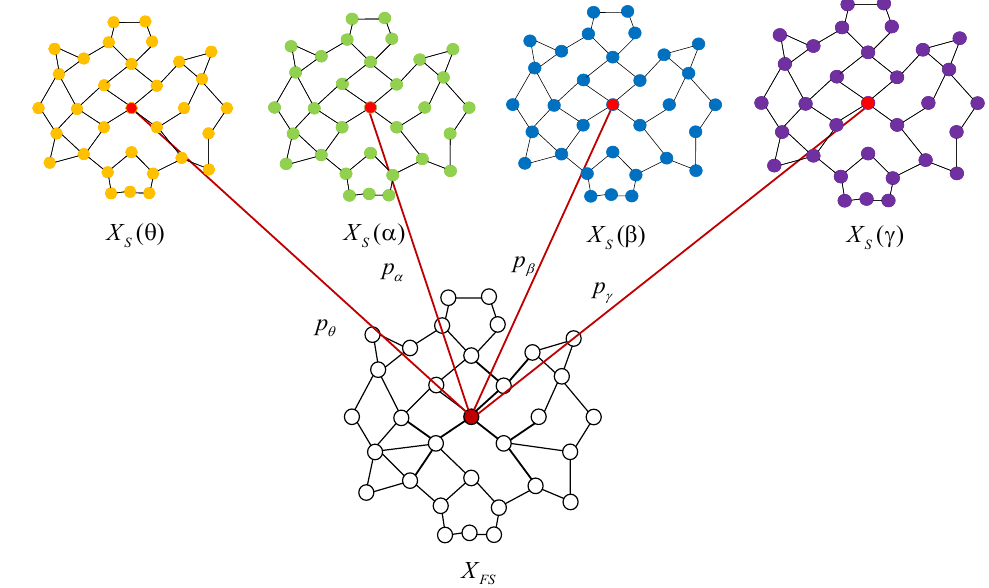
Figure 4. The fusion processes of the proposed F-GCN method for X S